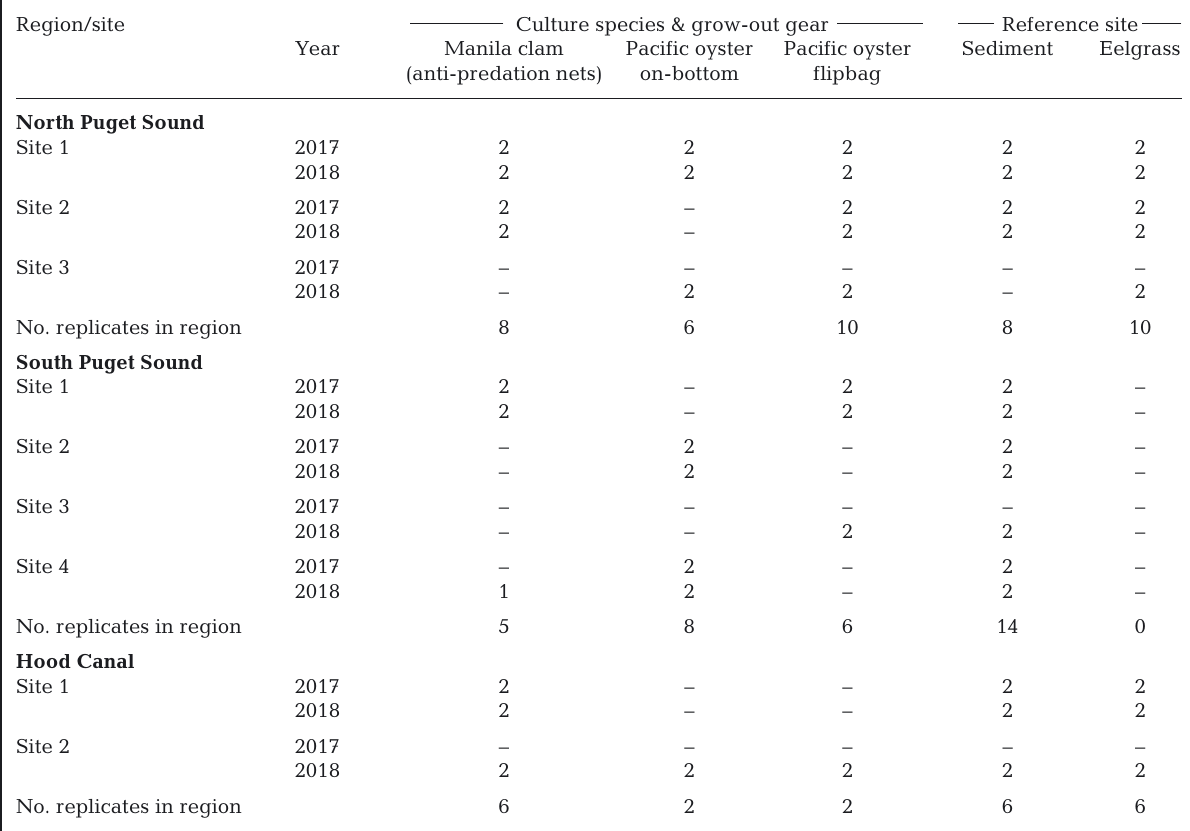
Table 2. Number of times each mesohabitat type (aquaculture and reference) was sampled at each site and region, from June to August of 2017 and 2018. One sampling event equates to 2 days of video, of which ten 2 min video segments from 1